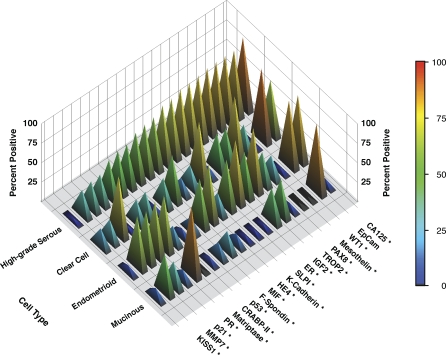
Biomarker Expression Rates in the Entire Cohort by Subtype*Significant differences between categories (Fisher's exact test). Note that the order in which biomarkers are presented is based on percentage of positivity and that therefore the order is different in Figures 2–4.